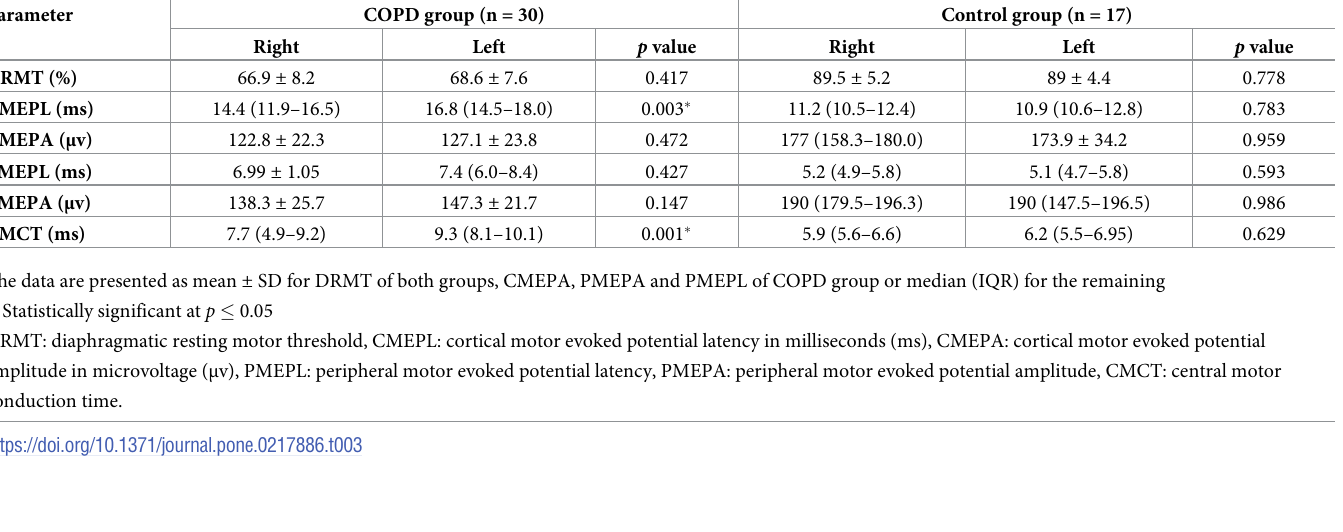
there was no statistically significant correlation between diaphragmatic CMEPs, PMEPs or